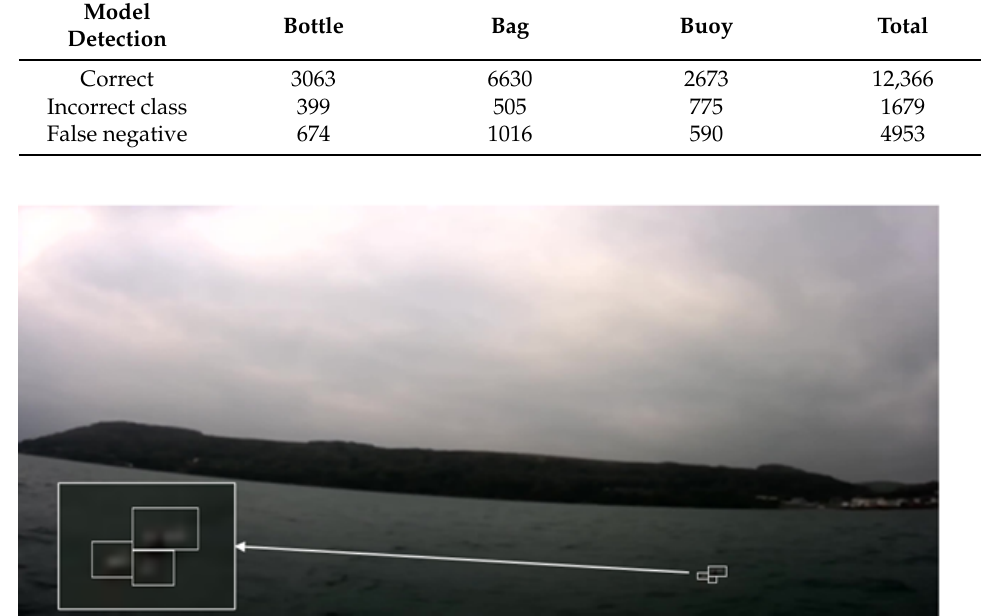
Figure 9. Example of one of the false negative images from the validation data set. The image contains three small bottles which have drifted away from the vessel. The percentage cover of each bounding box is 0.033%, 0.015% and 0.007%.